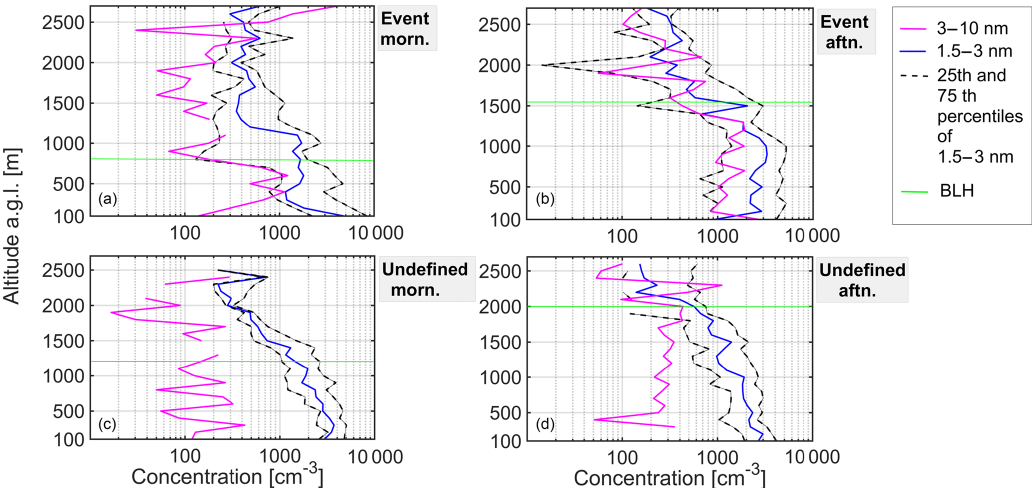
Figure 3. Median concentrations in two size ranges (1.5–3 and 3–10nm) and 25th and 75th percentiles of 1.5–3nm particle concentration over measurement profiles during event and undefined days separately for morning (a, c) (07:00–12:00) and afternoon (b, d) (12:00–15:00). The median vertical profiles were defined over 9 event mornings, 8 event afternoons, 18 undefined mornings and 16 undefined afternoons. Median boundary layer heights are marked by green lines.